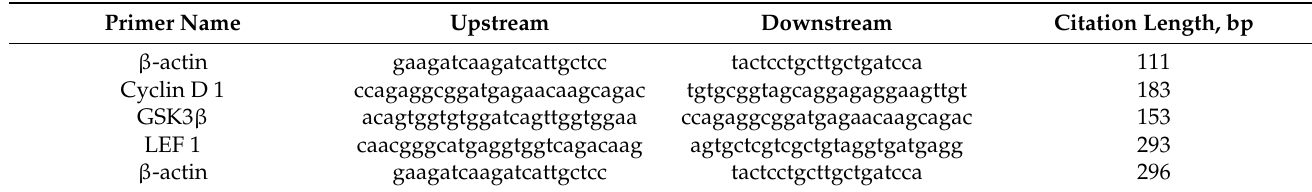
Table 6. Primers and base sequences used in detection.